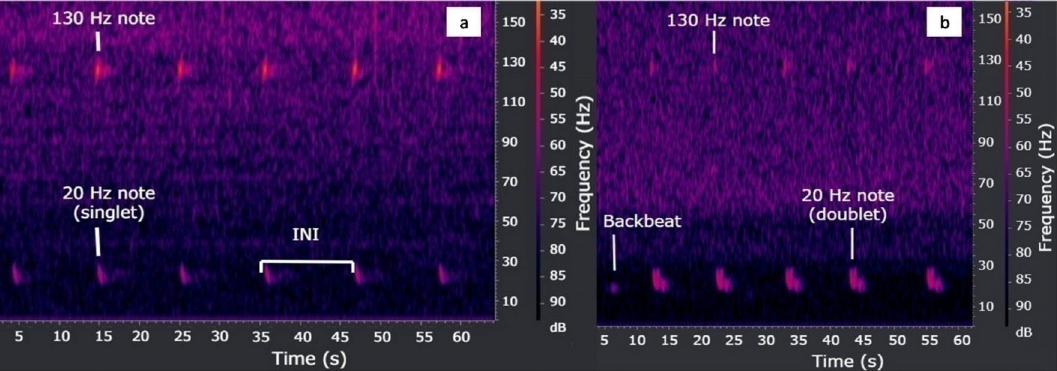
Figure 2. Spectrograms (Hamming window, FFT = 1024, overlap = 87.5%) of fin whale songs consisting of ( a ) 20 and 130 Hz notes indicating the inter-Note-Interval (INI), measured from the beginning of a note to the